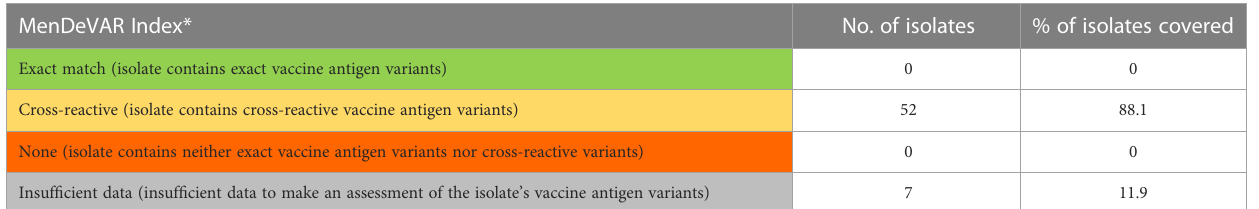
TABLE 5 Predicted coverage of MenB isolates by the MenB-Fhbp vaccine according to the MenDeVAR Index method. MenDeVAR Index* No. of isolates % of isolates covered Exact match (isolate contains exact vaccine antigen variants)